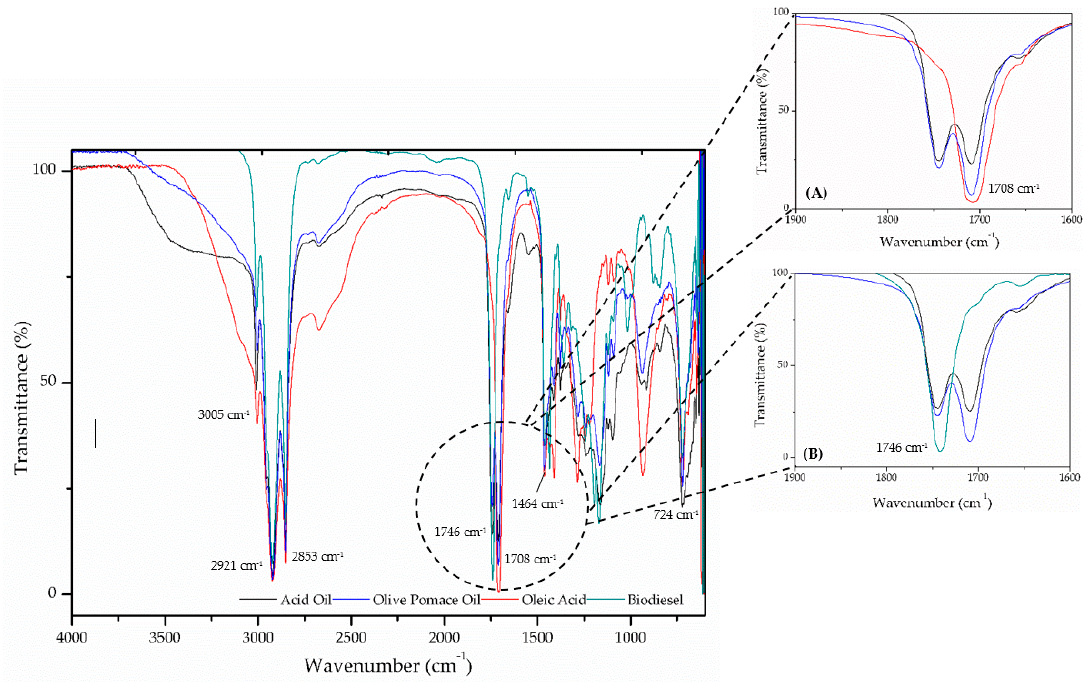
Figure 1. Fourier transform infrared (FTIR) spectrum of feedstocks and reference standards. ( A ) Identification of free fatty acid (FFA); ( B ) identification of fatty acid methyl ester (FAME).